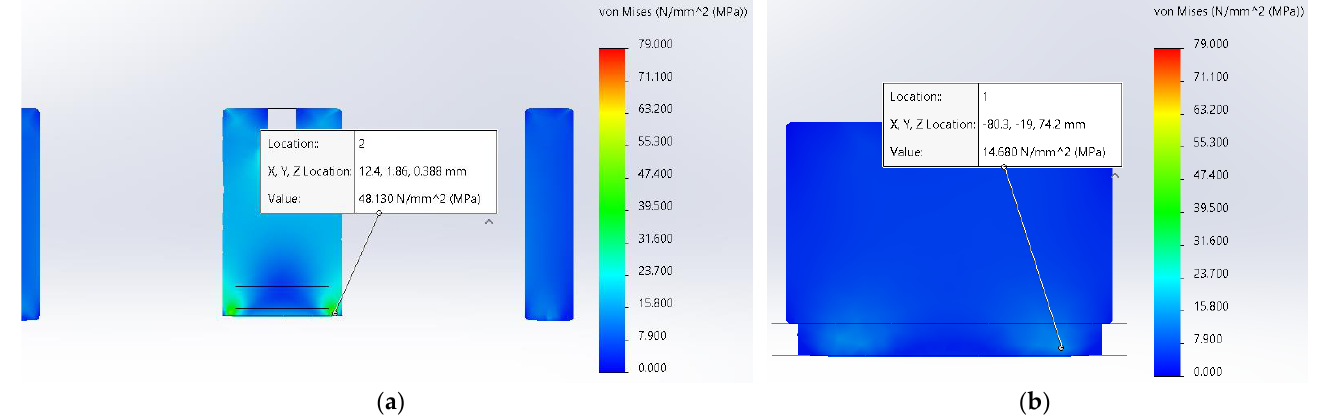
Figure 11. Von Mises equivalent stresses for the pillar structural validation: 24 V ( a ) and 48 V assemblies ( b ).